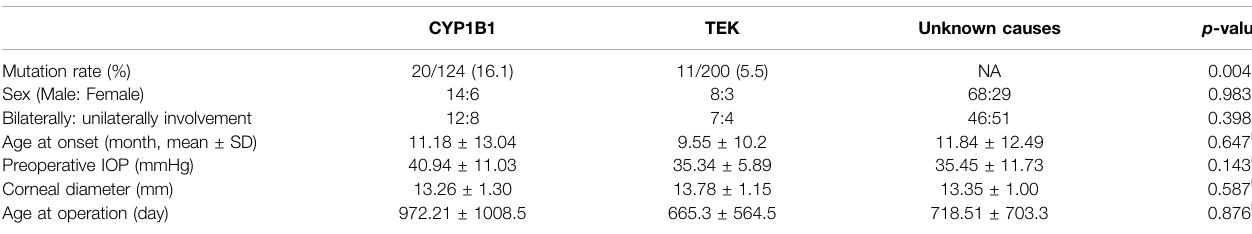
TABLE 4 | Comparison of clinical characteristics of PCG